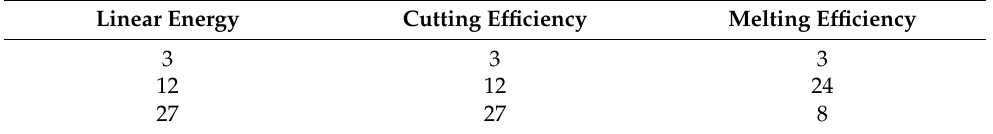
Table 10. Parts classification.